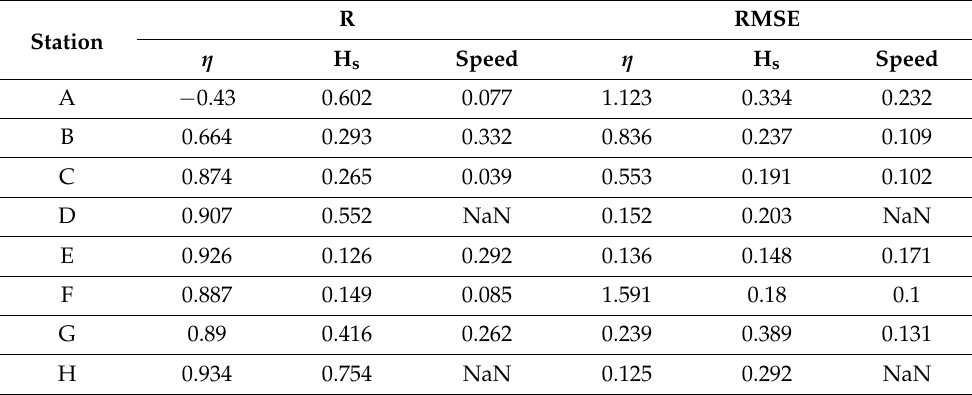
Table 2. Model performance of surface elevation, significant wave heights, and current speed for all the sensors (see the location in Figure 2b) during 23 August–4 September